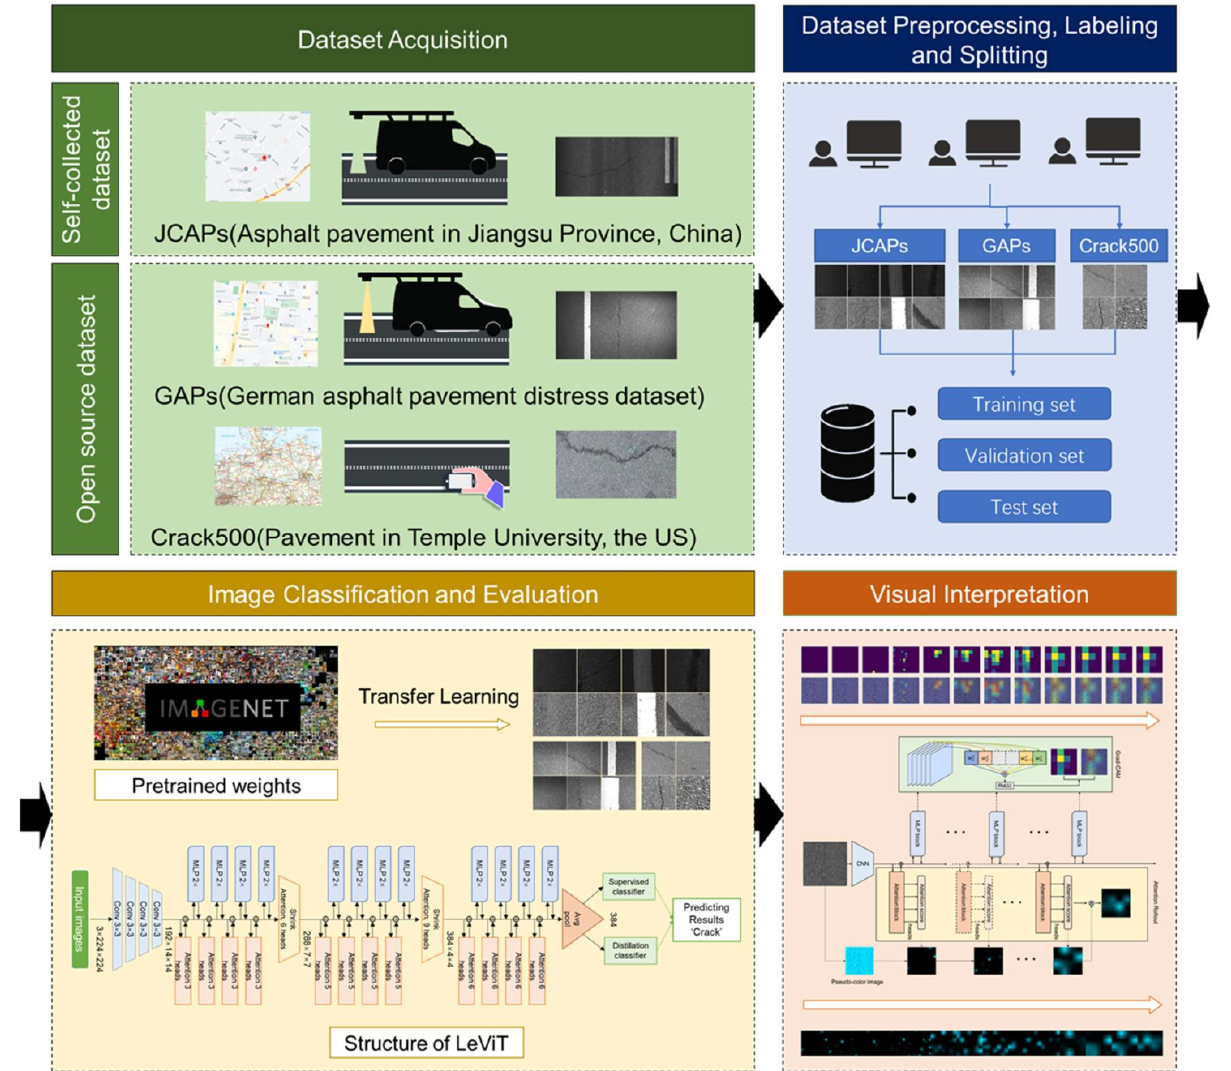
Figure 1. The framework of the proposed